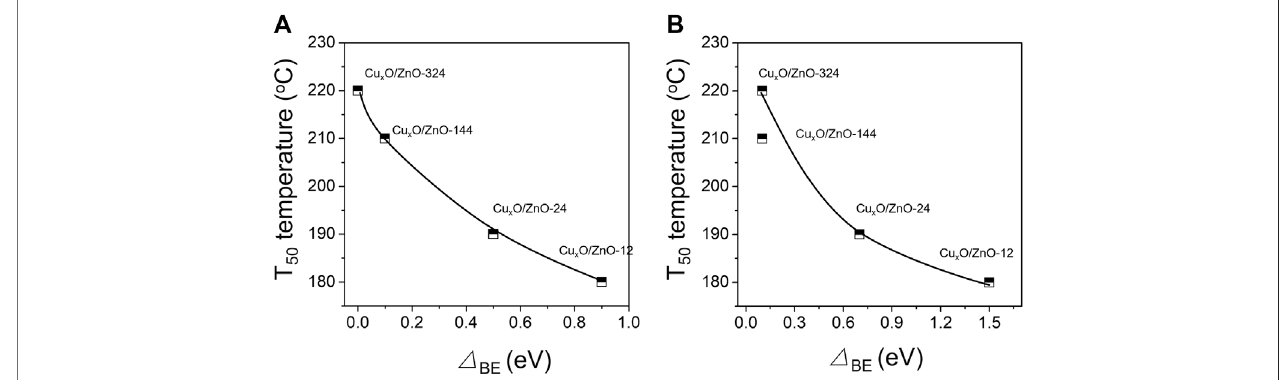
FIGURE 8 | (A) Dependence of the T 50 temperature and the difference between the Cu 2p 2/3 peak position of the used catalyst and the peak position for Cu (933.4 eV); (B) dependenceoftheT